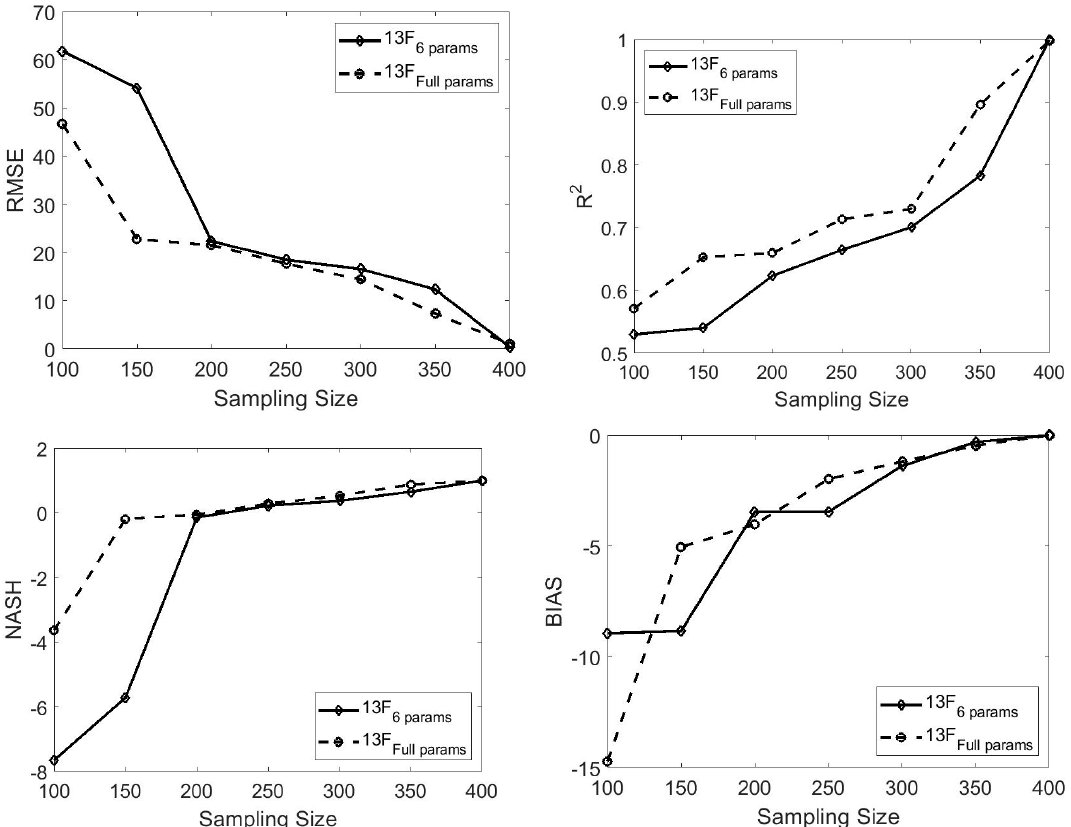
( b ) Figure 5. Fragility curves using 6-floor structure for ( a ) 100 sampling size with IO (upper left), LS (center left), and CP (lower left) levels, and ( b ) 400 sampling size with IO (upper right), LS (center right), and CP (lower right) levels. 4.2. Thirteen Floor Building Analysis for Development of the Rapid Prediction Model The GPR model is also examined for the 13-floor building, which has more degrees of freedom than the six-floor building. The six-parameter-based and 13-parameter-based models are used to produce the maximum displacement with fragility curve. To assess the model performance, four statistical indices are applied for the results obtained from